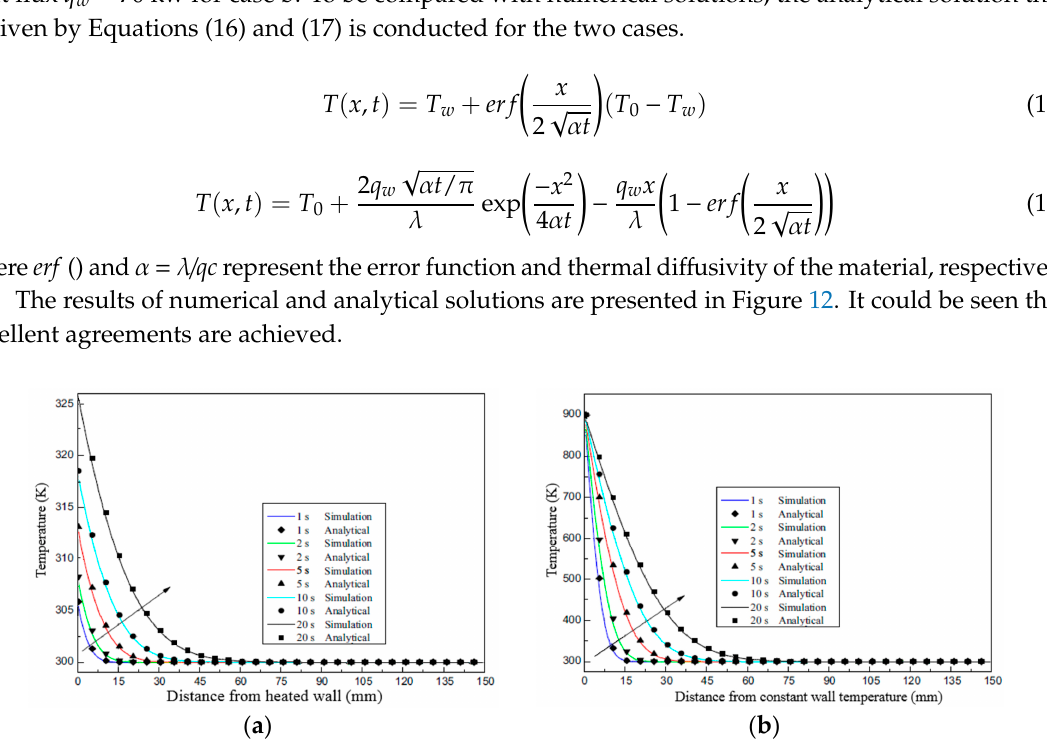
Figure 11. The composition distributions of simulation and experiment.